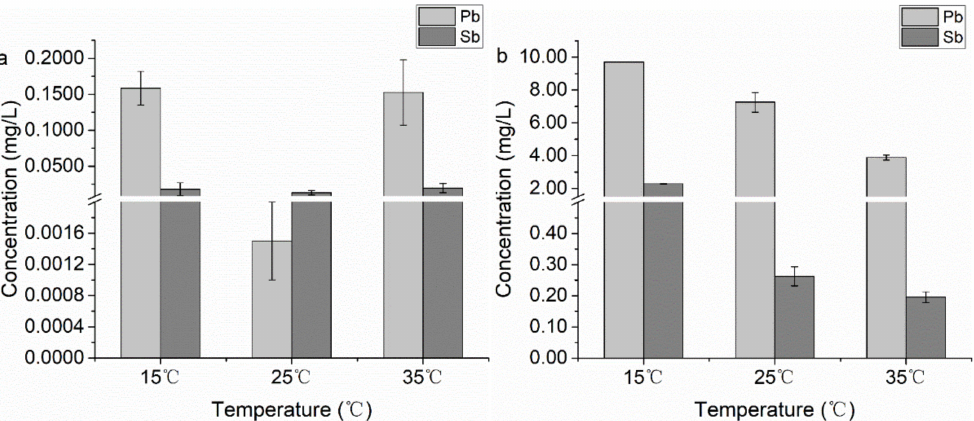
Figure 6. B. subtilis bioleaching of Sb(III) and Pb(II) pollution in the long-term contaminated real soil from battery manufacturing industries areas depending of different pH and temperature. ( a ) pH = 2.00, ( b ) pH = 6.00. Bars represent means ± SD (with three